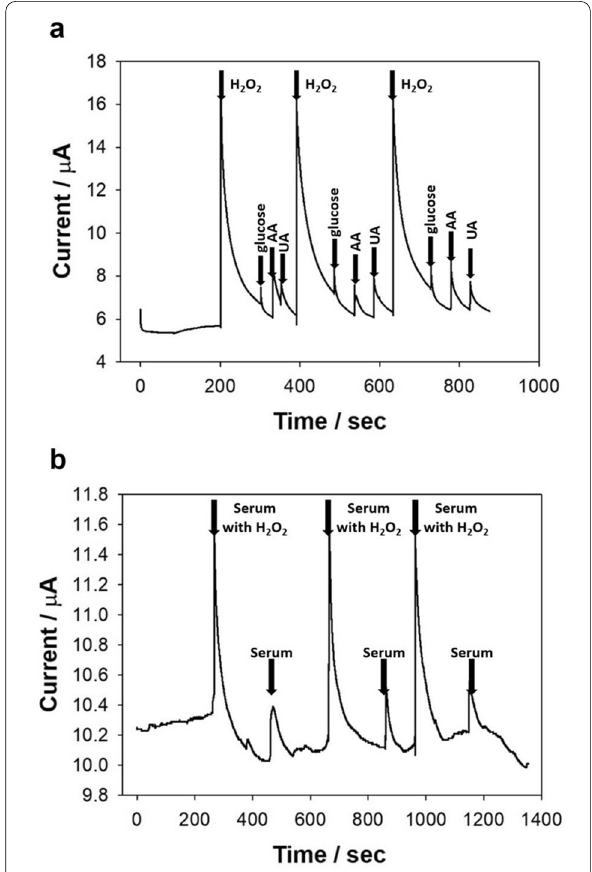
Fig. 5 Amperometric responses of the HEPNP/rGO/Au electrode for: a H 2 O 2 , glucose, ascorbic acid, and uric acid at the